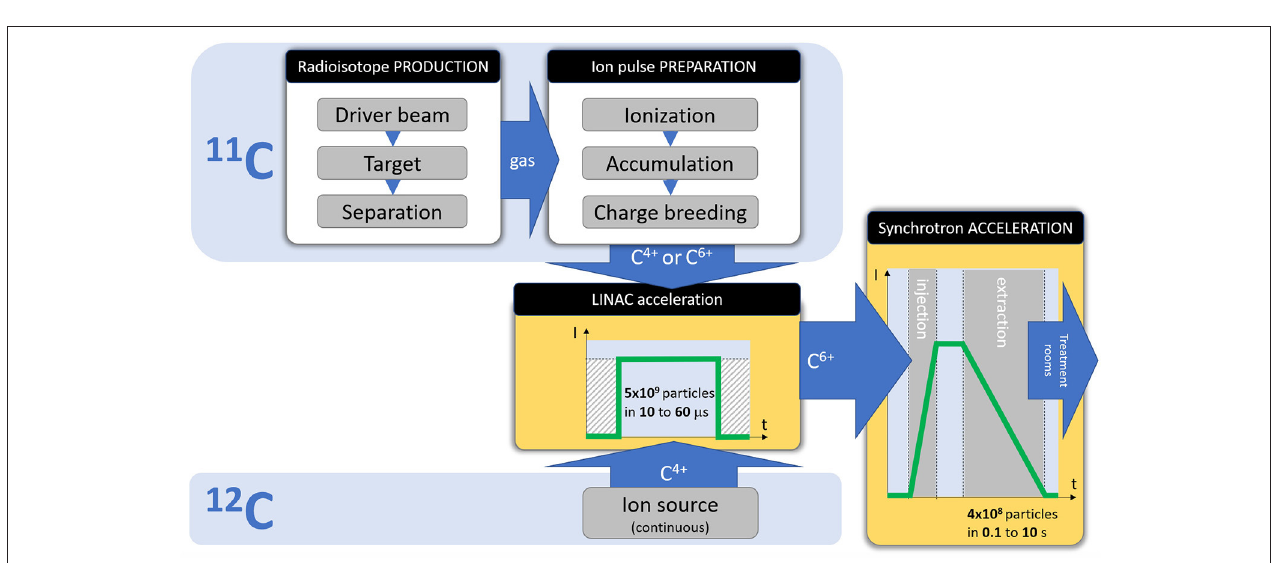
FIGURE 1 | Possible ISOL-type 11 C beam production system, proposed by NIRS (84).